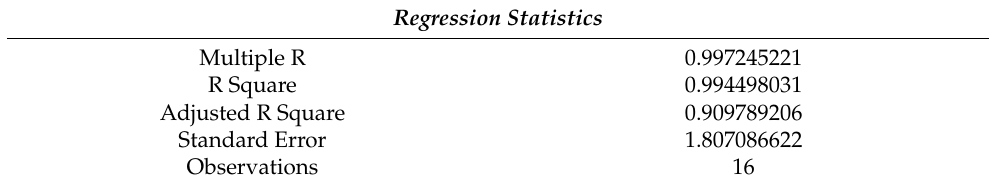
Table 9. Regression statistics by ANOVA.